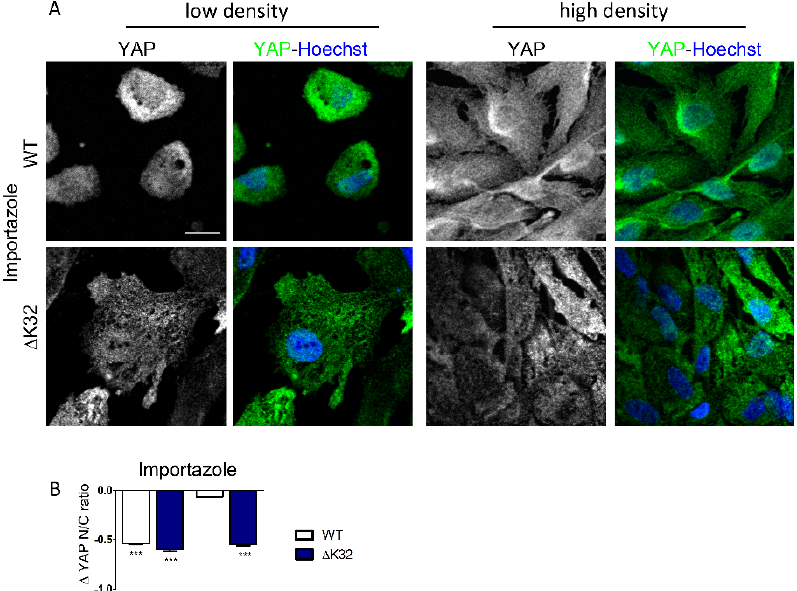
Figure 4. Importazole inhibits nuclear localization of YAP in WT and mutant MuSCs. ( A ) Confocal images of YAP (green) in WT and LMNA ∆ K32 mutant MuSCs cultured in low and high density conditions. Nuclei are stained with Hoechst (blue). Scale bar: 20 µ m. ( B ) Quantification of YAP nucleo-cytoplasmic (N / C) ratio after importazole treatment. Values are expressed as mean ± SEM, as a fraction of value obtained before importazole treatment, n ≥ 60 cell in each cell line.